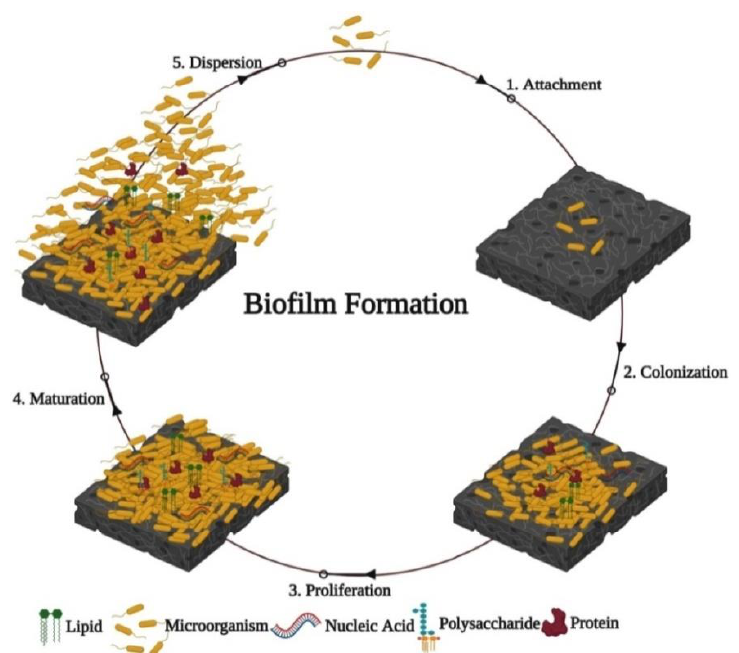
Figure 2. Developmental stages involved in microbial biofilm formation (From [58] with permission from Frontiers in Microbiology).